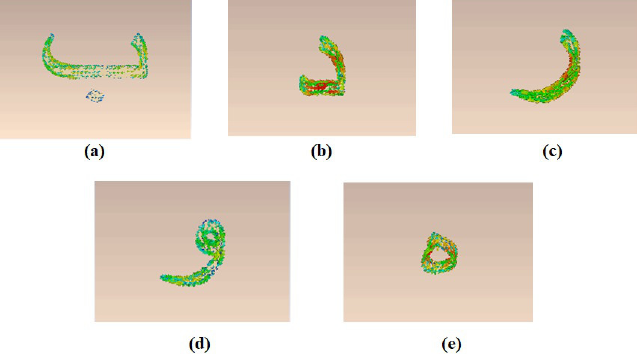
Figure 4. Current distribution of selective designed Arabic tags at their resonance frequencies: ( a ) letter H. ; ( b ) letter X ; ( c ) letter P ; ( d ) letter (cid:240) ; ( e ) letter Ł .